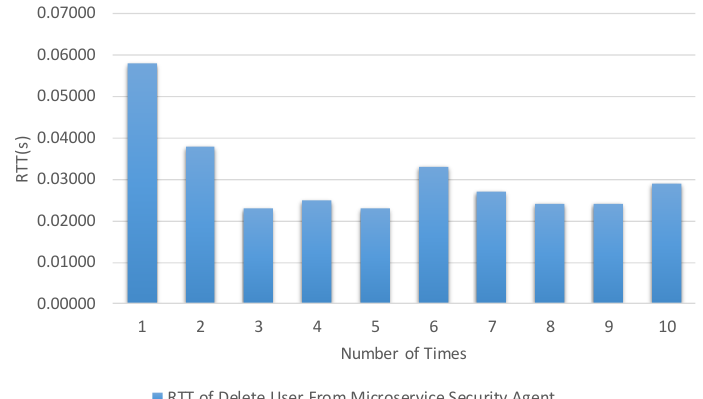
Figure 14. Round trip time for deleting a user based on the delete API for user